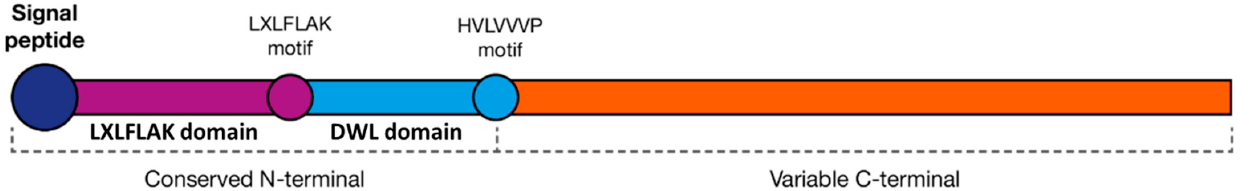
Figure 5. Phytophthora CRN effector structure. Diagram illustrating the LXLFLAK and DWL domains, which contains the characteristic motifs within the N-terminal and C-terminal. Featuring two conserved motifs (LXLFLAK and HVLVVP) in the N-terminal, followed by a variable C-terminal. CRNs do not always possess a signal peptide, as there are other secretion pathways.